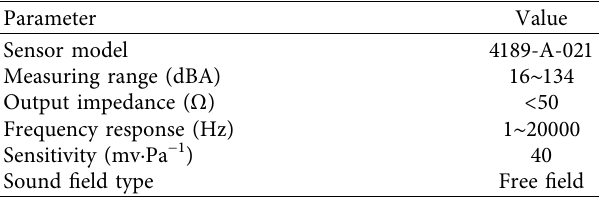
Table 1: Main technical parameters of the microphone.